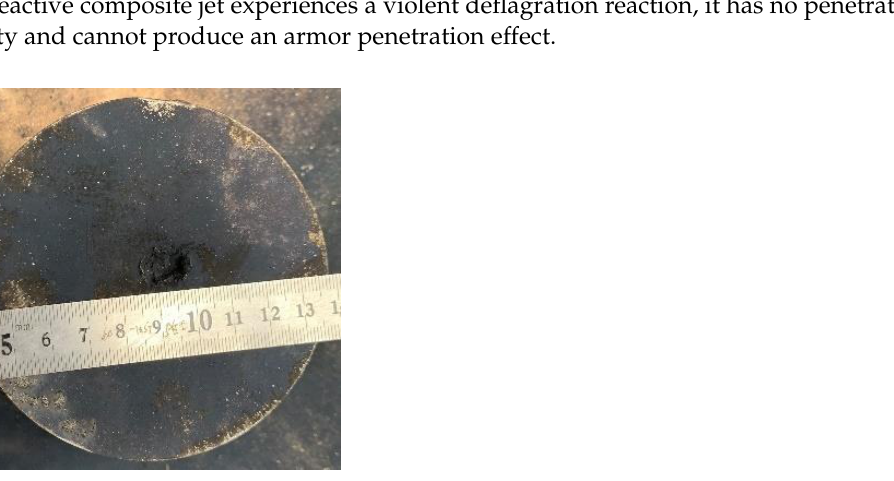
Figure 20. Experimental result of the steel plate impacted by the PTFE/Al reactive composite jet.